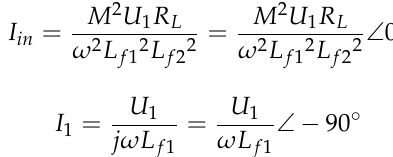
Figure 16. Simplified circuit model of the MCR-WPT system.